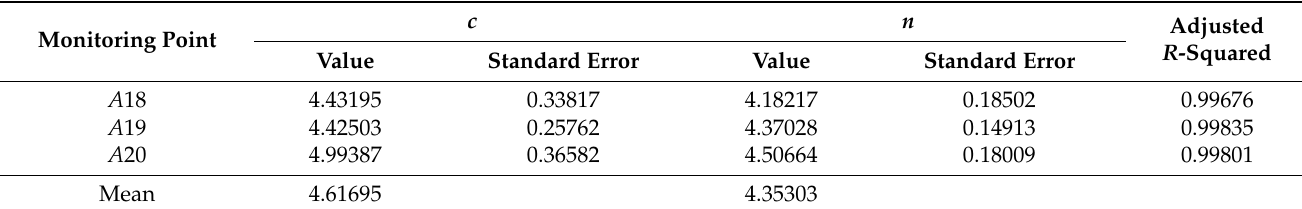
Figure 9. Fitting effect of new model for different monitoring points. Table 3. Fitting accuracy of new model for different monitoring points.